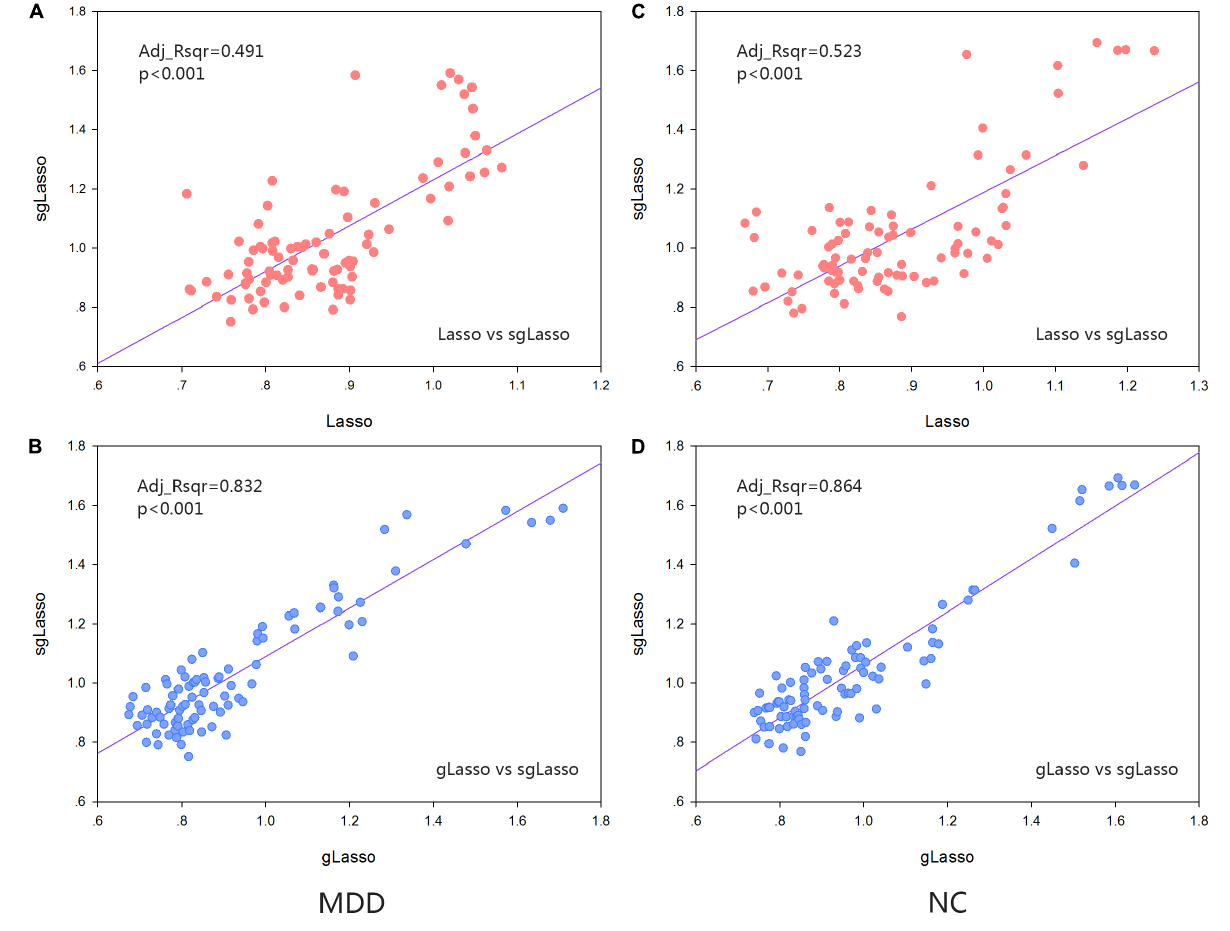
with the gLasso method (HCC indicator: Adj_Rsqr = 0.727